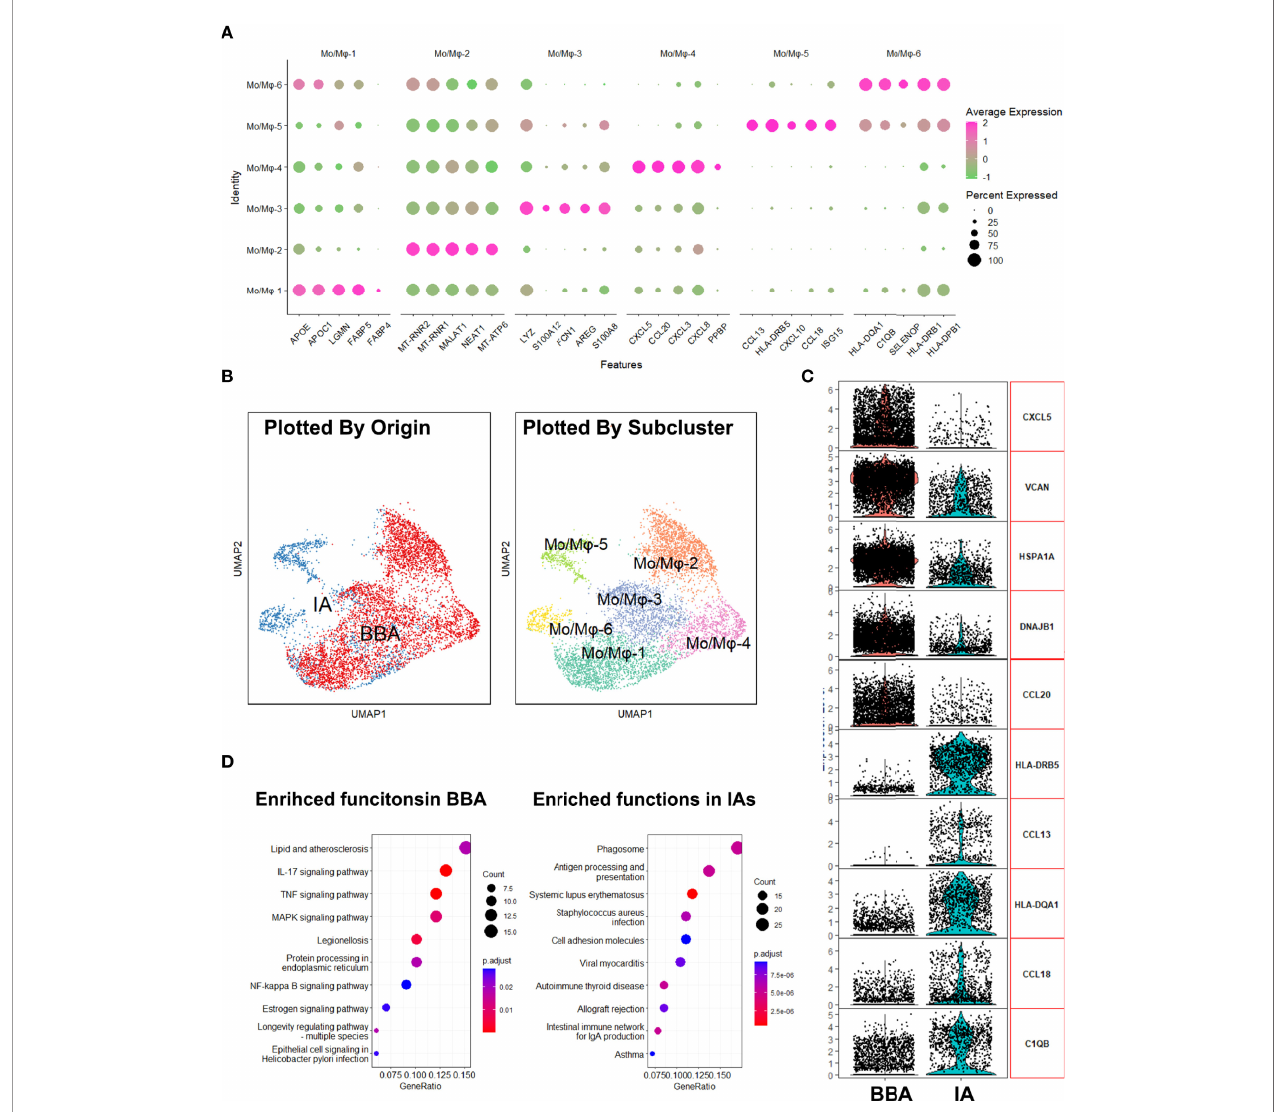
FIGURE 3 | Analysis of macrophages in aneurysms. (A) Enriched gene plot of monocyte/macrophage clusters 1 to 6. (B) Different distributions of macrophages in uniform manifold approximation and projection grouped by different identities. (C) Differentially expressed genes in blood blister-like aneurysm (BBA)-derived macrophages and intracranial aneurysm (IA)-derived macrophages. (D) Kyoto Encyclopedia of Genes and Genomes plot showing enriched cellular pathways in macrophages derived from BBA and